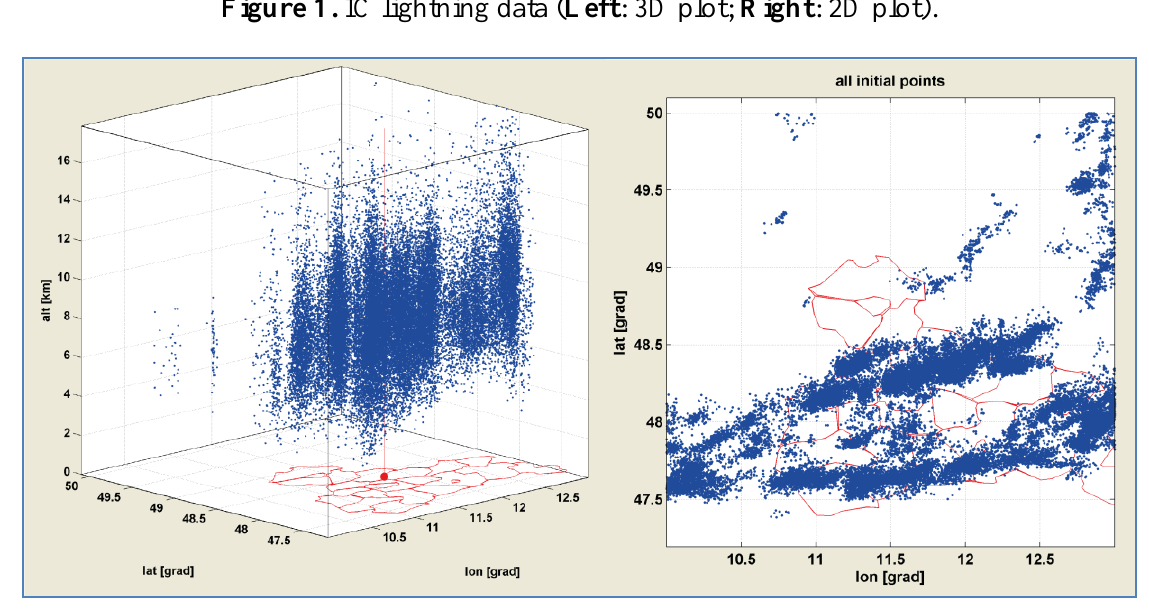
Figure 1. IC lightning data ( Left : 3D plot; Right : 2D